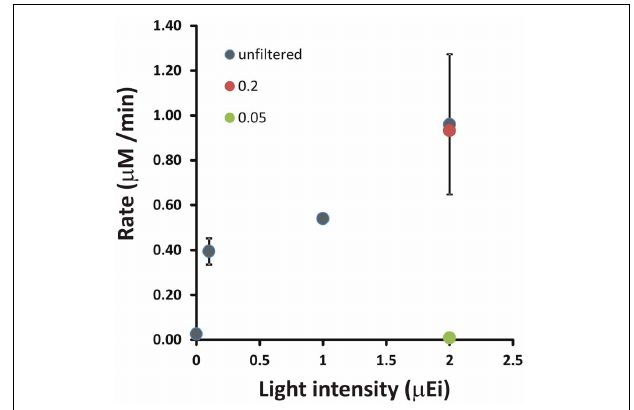
FIGURE 2 | A demonstration of light-stimulated sulfide oxidation in a shipboard incubation experiment with Chesapeake Bay waters. Light intensity indicates the measured incident PAR for the incubation experiment. Rates were determined by linear regression of [HS − ] vs. time for incubations under each condition. Error bars are the standard deviation of rates calculated from at least two independent incubations.